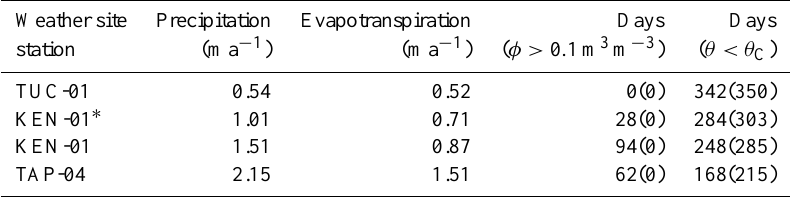
Table B1. Effect of presence of restricted soil layer on simulated total duration of low aeration ( φ > 0 . 1m 3 m − 3 ) or low soil moisture status ( θ < θ C ) for the four precipitation scenarios shown in Fig. B1. In all cases the evapotranspiration rate refers to that estimated for a soil with a restricted layer at 0.3m depth with the number of days calculated and compared (with in brackets) that predicted to be the case in simulations giving the same annual evapotranspiration rate but with no restricted layer present: KEN-01 ∗ is all rainfall events at KEN-01 multiplied by 0.7. (see